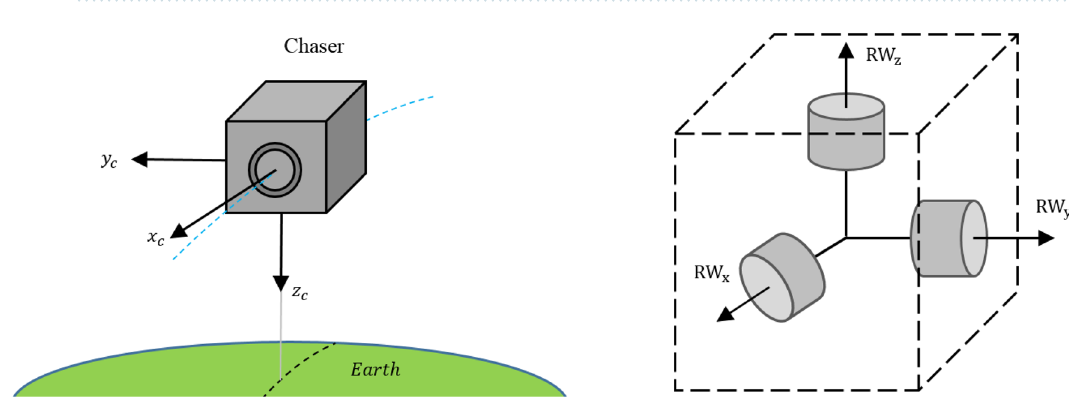
Figure 4. Position control thrusters of the chaser spacecraft.